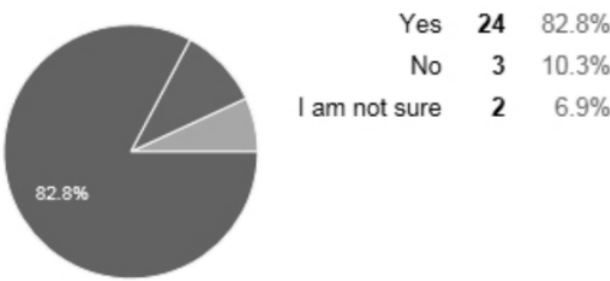
Figure 8. Distribution of responses to question Q2, asking whether the respondent was willing to use AergiaML-like languages in the